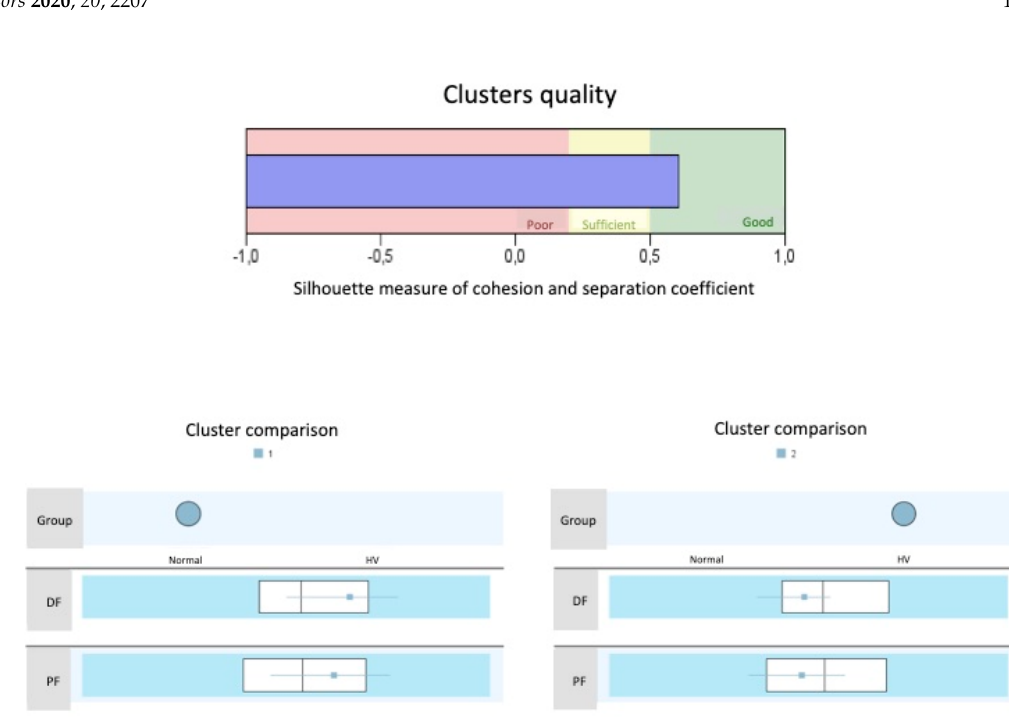
Figure 6. Cluster graphic. A silhouette measure of cohesion and separation coe ffi cient of 1 means that all cases are in their cluster centers. A value of -1 means that all cases are in the centers of other clusters to which they do not belong. A value of 0 means that, on average, the cases are equidistant between the center of their own conglomerate and the center of another nearby conglomerate. Therefore, a result in the “Good” zone means that the data strongly evidence the structure of the conglomerates. A result in the “Su ffi cient” area means that the data show this cluster structure in a less evident way, and a result in the “Poor” area reflects that the data does not provide significant evidence of the cluster structure. DF = Dorsiflexion; PF = Plantarflexion. Table 5. Values of the total ROM of the first ray used in assembling the conglomerates for predicting normal or HV feet.